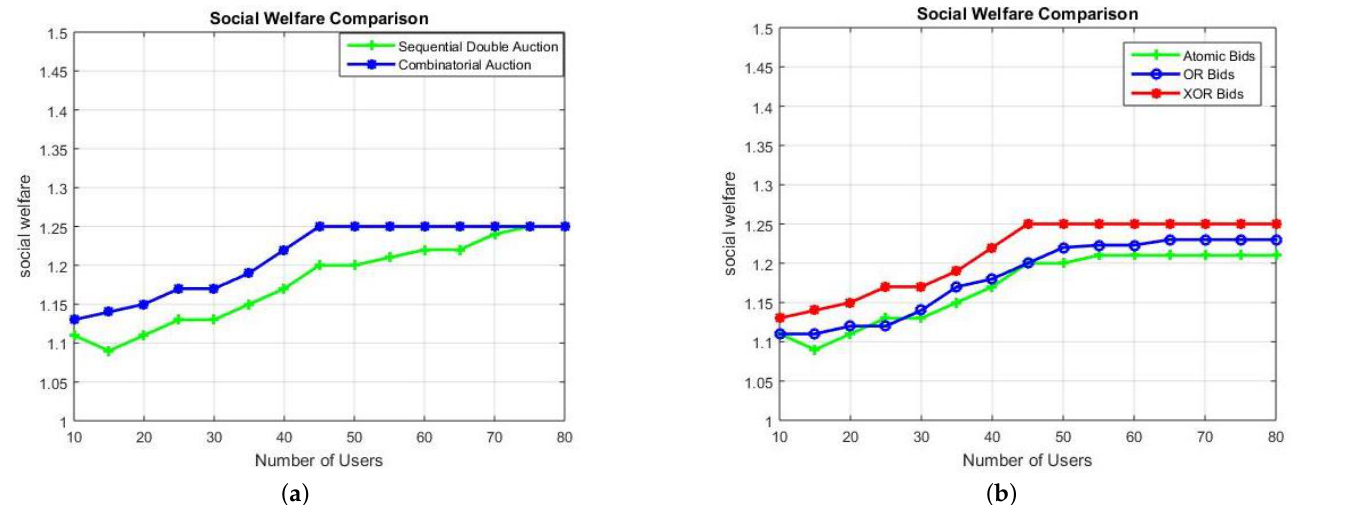
Figure 9. ( a ) Social welfare comparison ( b ) social welfare comparison for different bid types in combinatorial